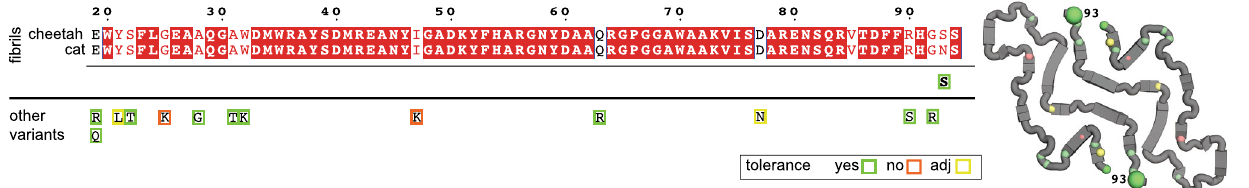
structure level (right). Substitution tolerance was estimated based on simple structural considerations, and colored in green (tolerated), yellow (tolerated with adjustments) and red (not tolerated). Cat AA amyloid is shown as gray cartoon. Large and small spheres highlight the positions of single-residue substitutions in fi brils and other SAA variants,